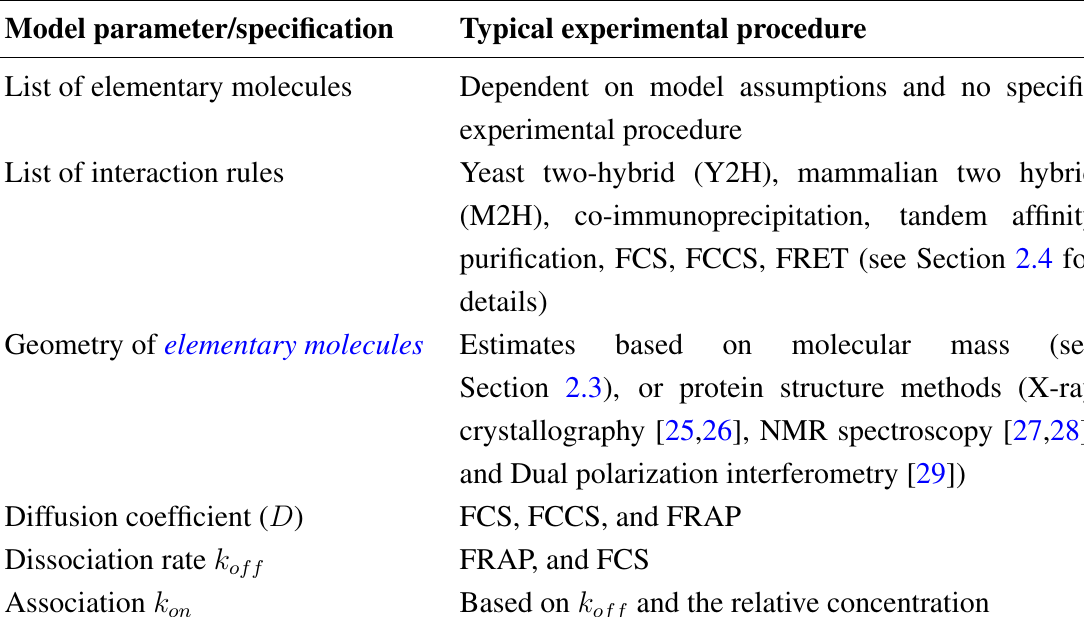
Table 2. Overview of the required model specifications and typical experiments for obtaining them. FCS, fluorescence correlation spectroscopy; FCCS, fluorescence cross-correlation spectroscopy; FRET, F ¨ orster resonance energy transfer; FRAP, fluorescence recovery after